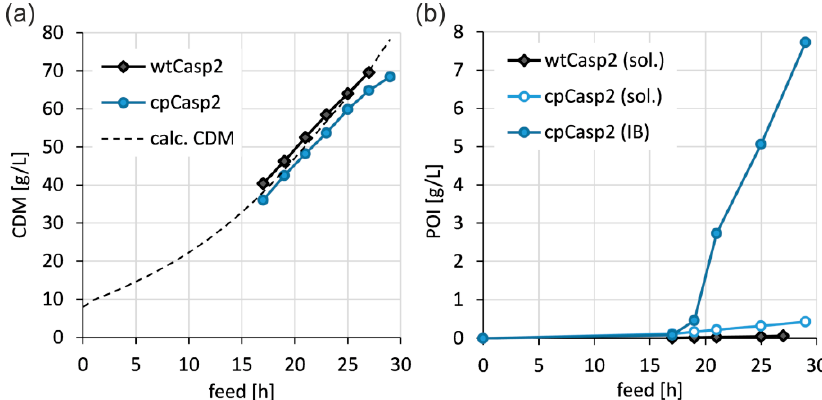
Figure 2. Direct comparison between wtCasp2 and cpCasp2 production during carbon limited fed-batch cultivation ( µ = 0.1 h − 1 ) with constant 0.5 µ mol IPTG / g CDM: biomass course: cell growth ( a ) and expression; ( b ) of soluble (sol.) and insoluble (IB) POI in the course of time as volumetric titer [g/L].